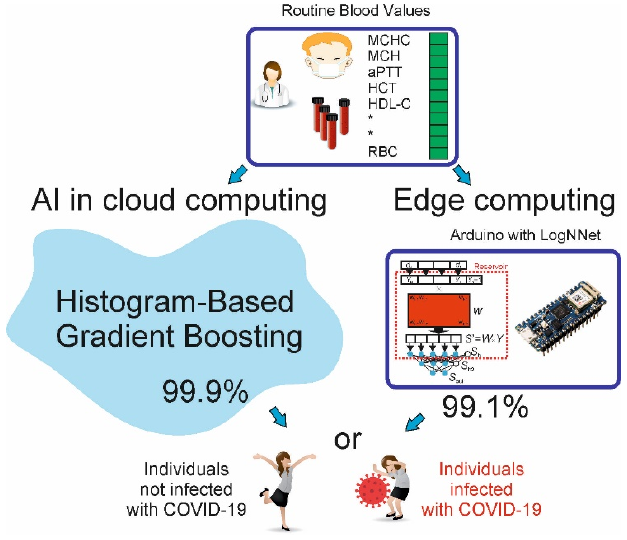
Figure 9. Two architectures of the IoT system, which includes an IoT device with LogNNet imple- mentation (edge computing) and a cloud service containing a trained HGB model (AI